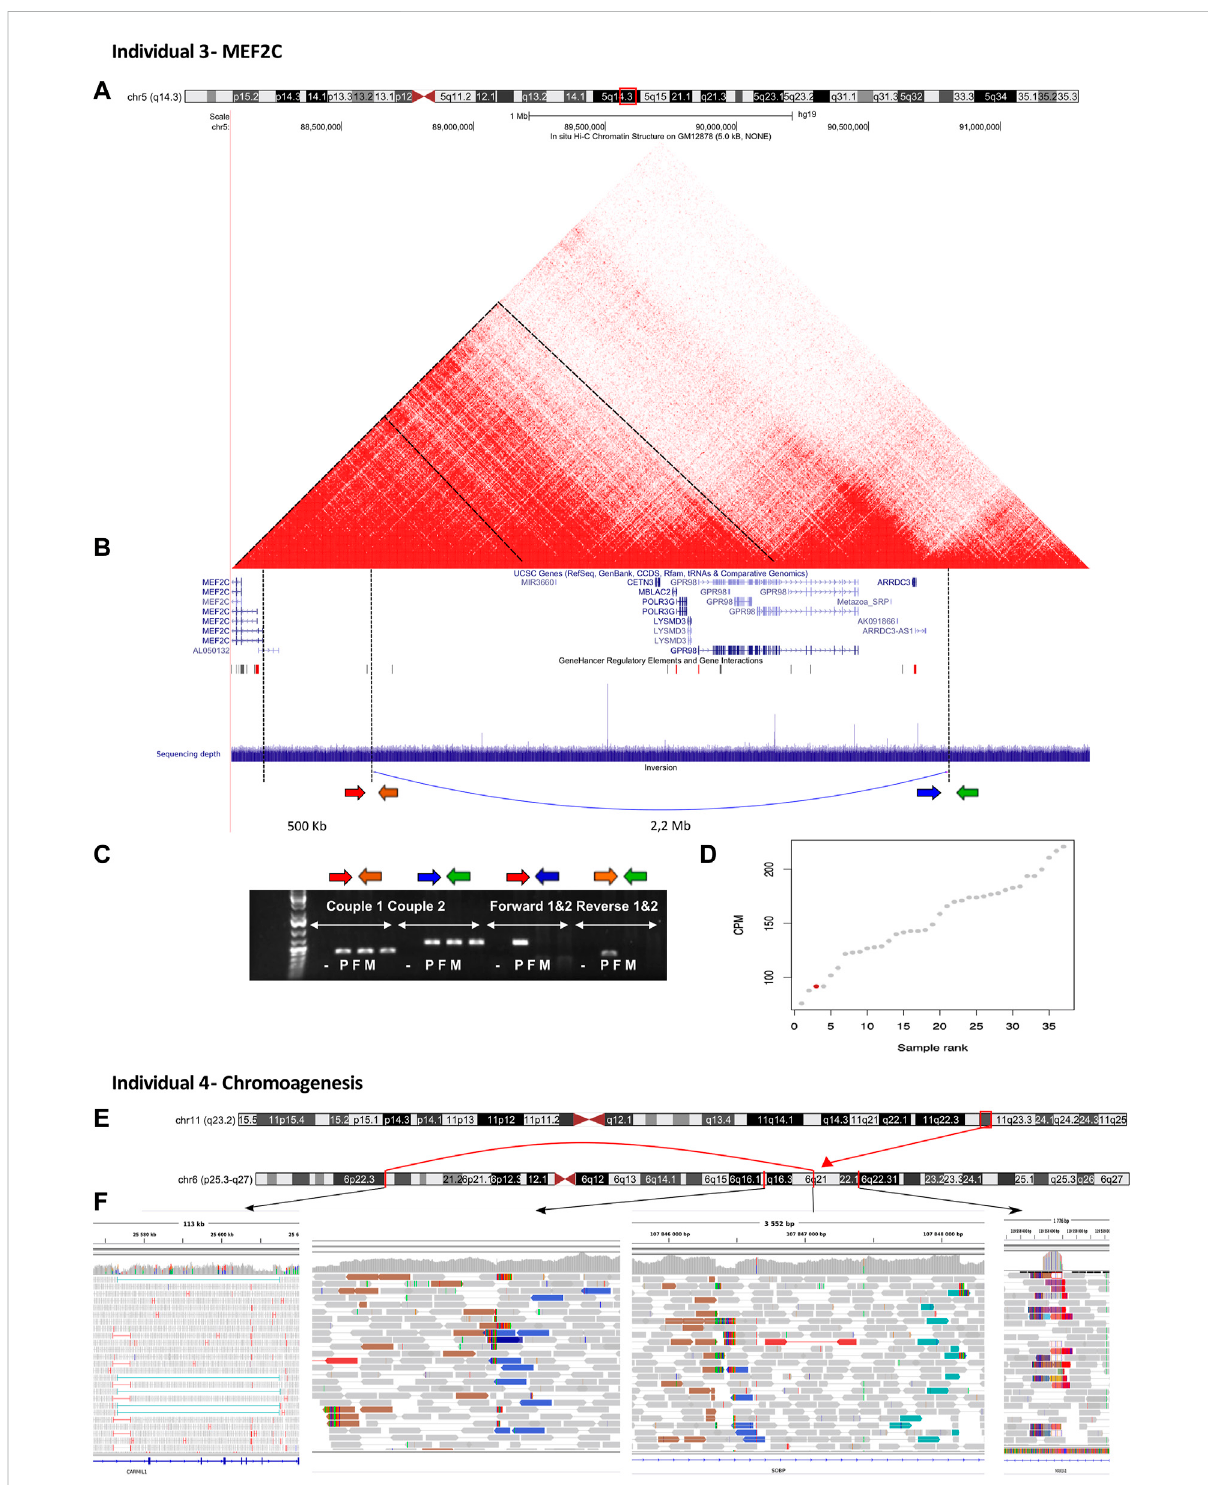
FIGURE 4 Illustration of individual 3 — MEF2C and individual 4 — Chromoanagenesis. (A) Ideogram showing chromosome 5 and MEF2C localization. (B) UCSC genome browser snapshot with visualization of three-dimensional (3D)-genome map at the 5q14.3 locus derived from Hi-C data of gM1287825 (10 kb resolution)andsequencingdepthofthisregion.Thestructuralvariantcharacterizedbya denovo inversionof2.2 Mbin5q14.3isshowninblueunderthe sequencing depthtrack. Itencompasses partof the regulatory regionresponsible for theneuronal expressionof the MEF2C gene.The inversiondid not include the gene body as it was located 500 Kb away from its proximal promoter region. This inversion is expected to deregulate MEF2C via its topologicallyassociatingdomaindysfunction. (C) PCRanalysiscon fi rmingtheinversion. (D) MEF2C expressionwithRNAsequencingdata.Therewaslow expression of the MEF2C transcript in the individual; however, its biallelic expression in blood suggested that the regulatory regions affected by this inversionwerespeci fi ctotheneuronallineage. (E) Ideogramshowingchromosomes11and6affectedbythecomplexrearrangement. (F) IGVvisualization of the breakpoint located in chromosome